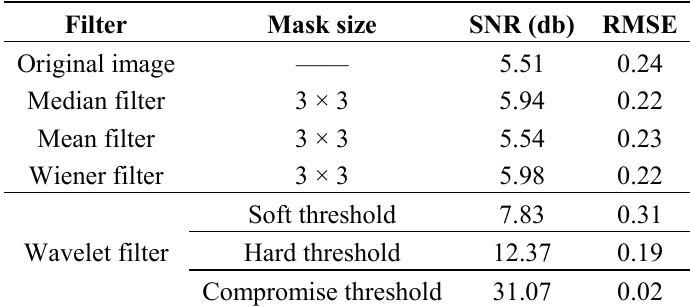
Table 1. Statistical analysis